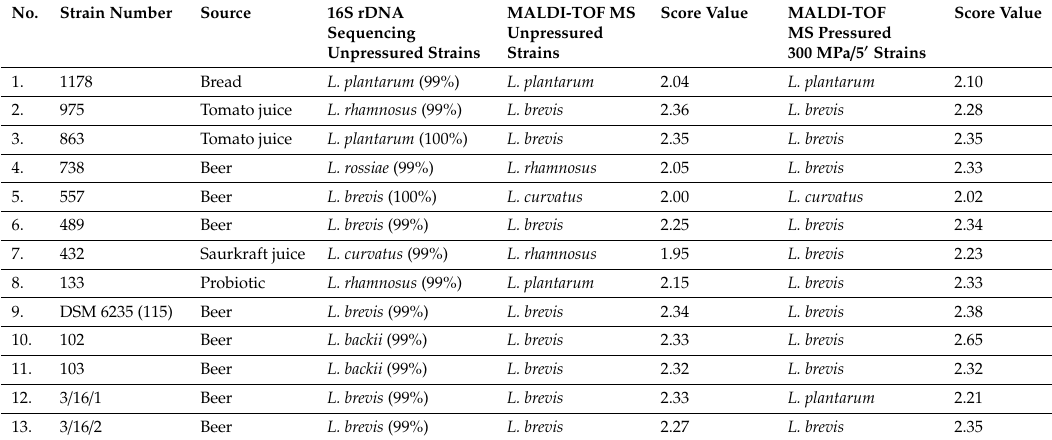
Table 1. Comparison of the results obtained for the unpressured and pressured samples by using the 16S rDNA sequencing and MALDI-TOF